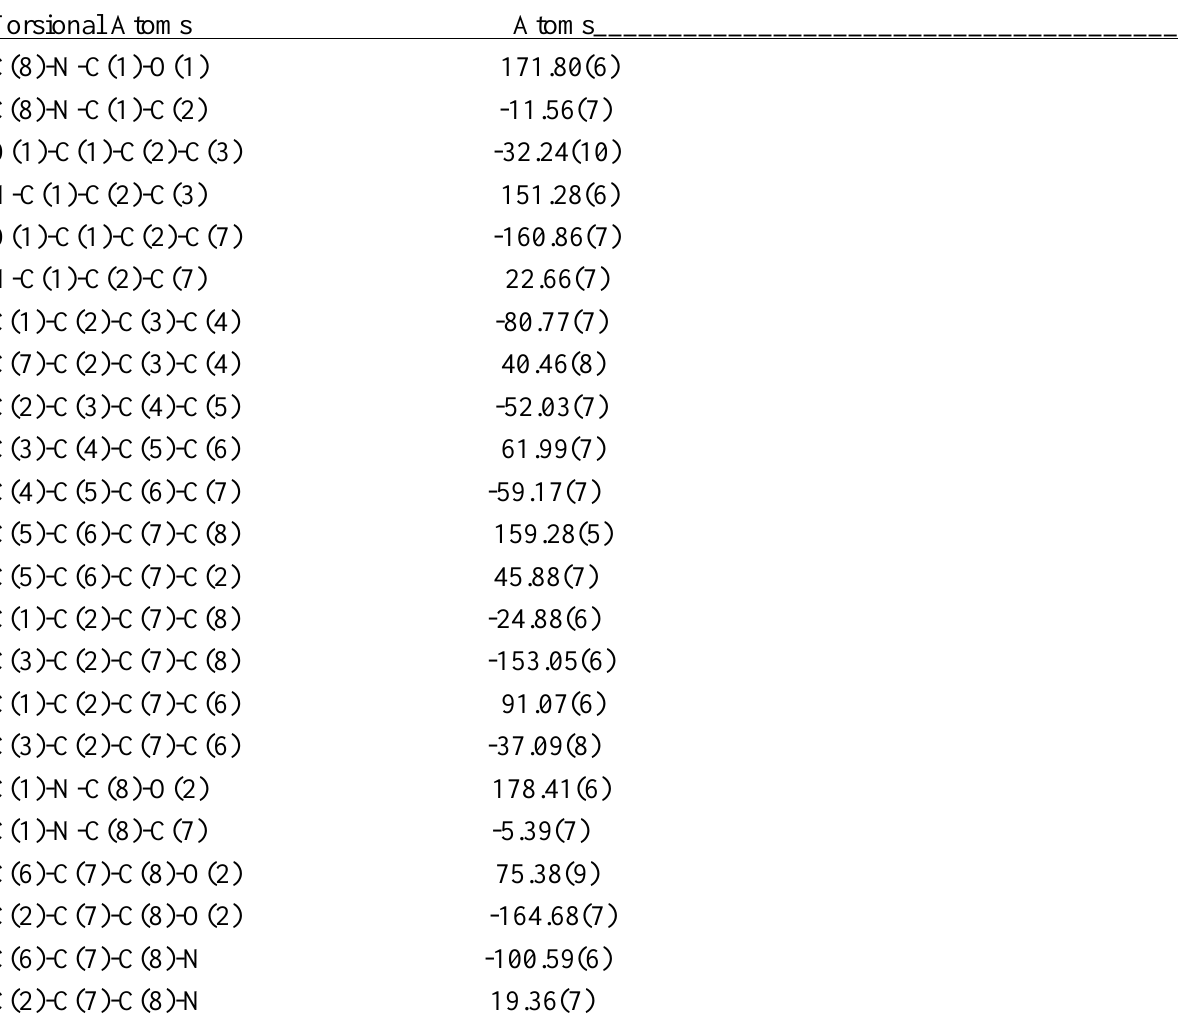
Table 7. Torsion angles [°] for for 3a,4,5,6,7,7a-Hexahydro-1H-isoindole-1,3(2H)-dione.________ Torsional Atoms